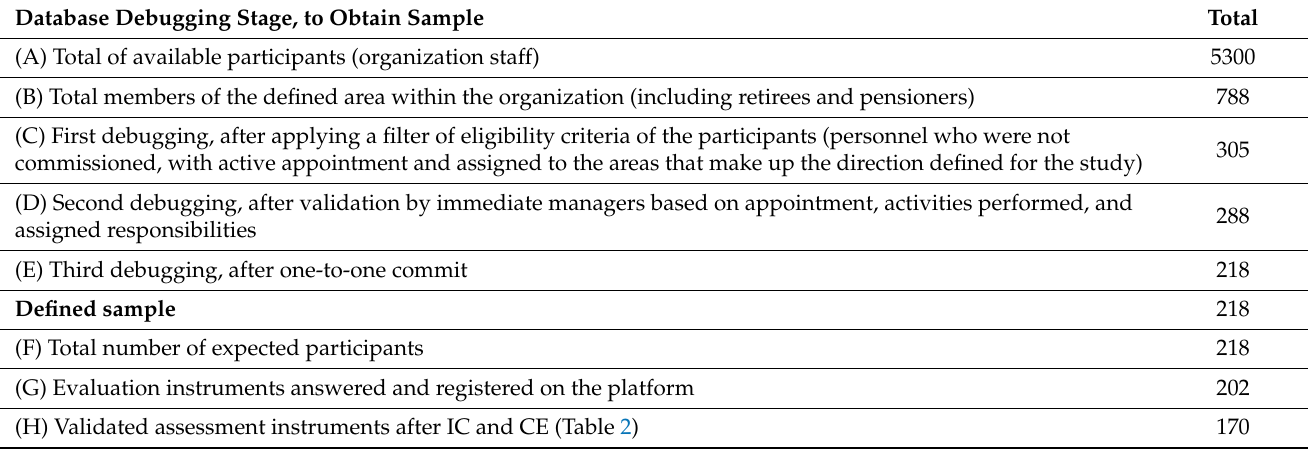
Table 1. Stages of database debugging based on the sample design.